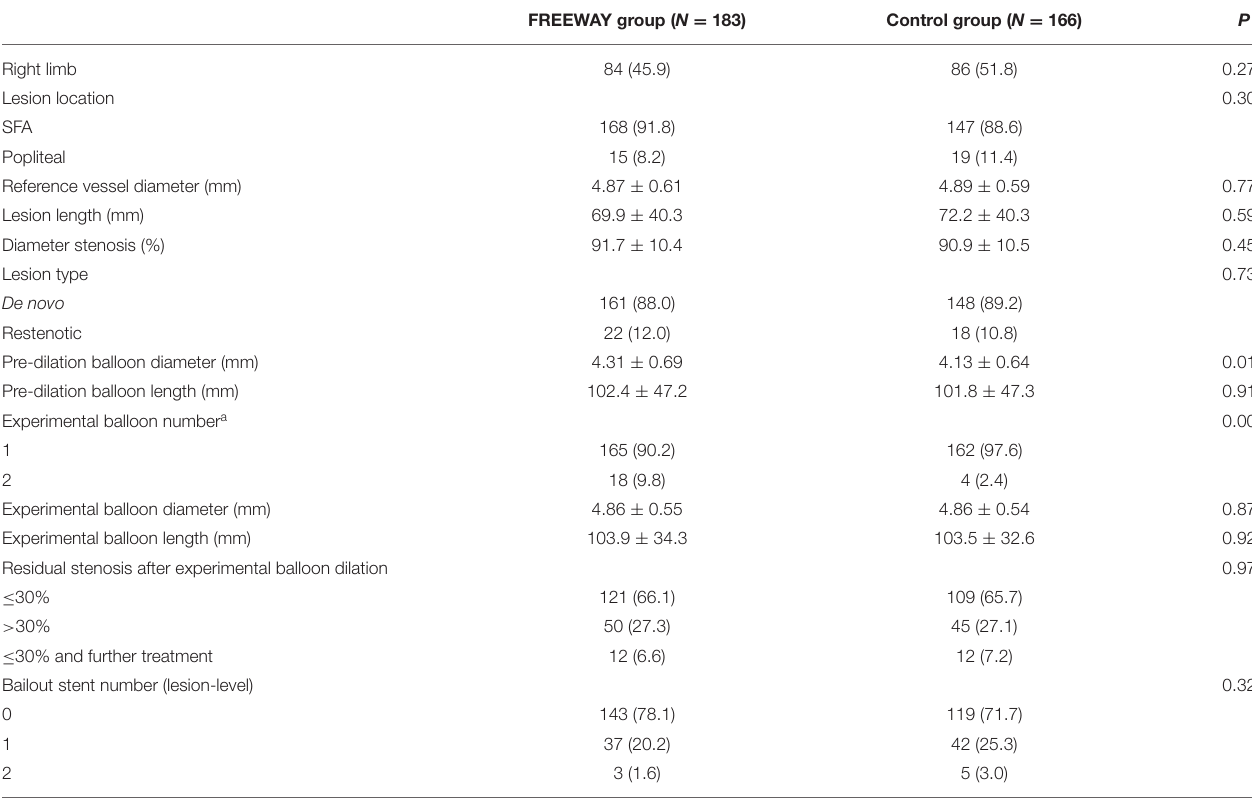
TABLE 2 | Lesion and procedural characteristics.